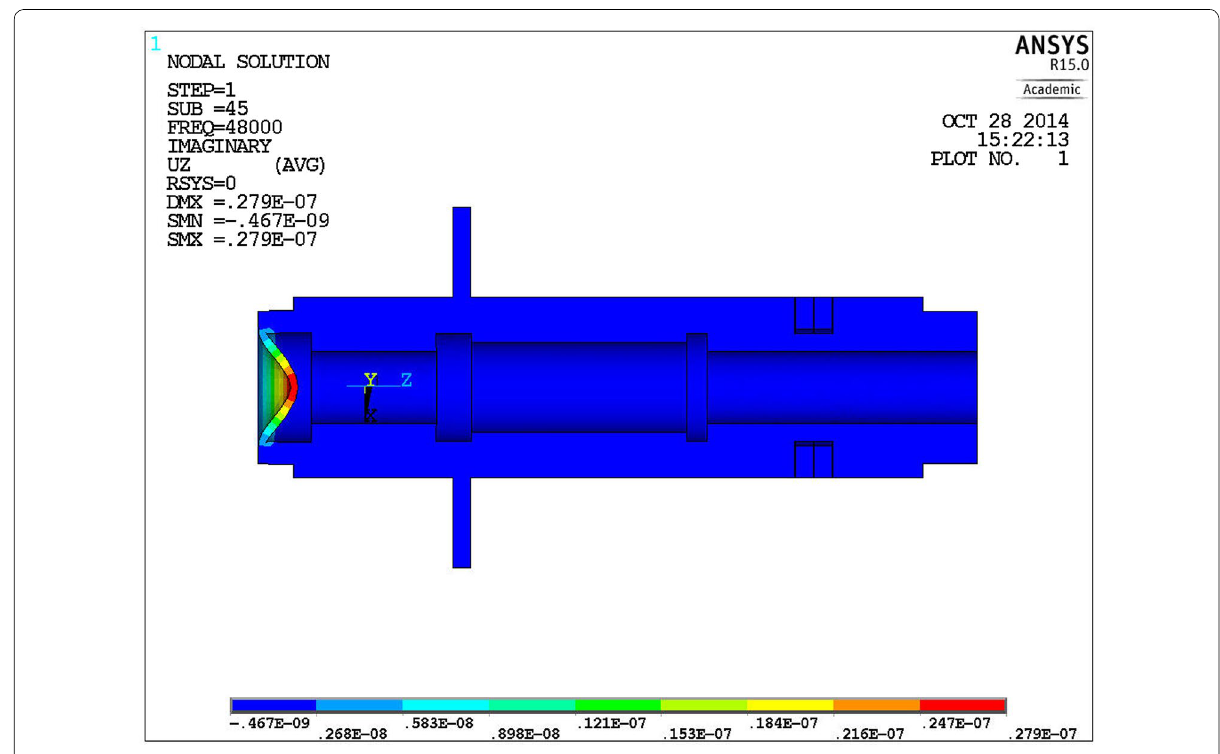
Fig. 4 FEM result of deformation mode of the prototype